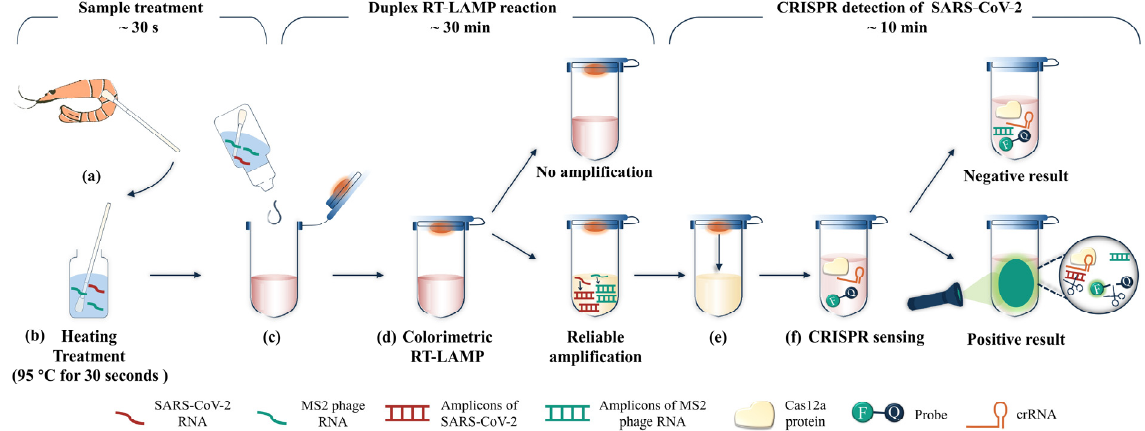
Figure 5. A schematic of the sensitive and reliable detection method for SARS-CoV-2 on spiked shrimp samples. ( a ) Sampling from the surface of shrimp. ( b ) Heating treatment for swab sample. ( c ) Adding one drop of target sample as amplification template. ( d ) Carrying out LAMP reaction at 65 °C. An additional heating step at 37 °C for 10 min will be included before amplification if there is amplicon contamination. ( e ) Mixing the CRISPR reagent which pre-added inside the tube lid with LAMP amplicons. ( f ) Carrying out CRISPR reaction at 37 °C for 10 min and observing the fluorescence results with an ultraviolet lamp.